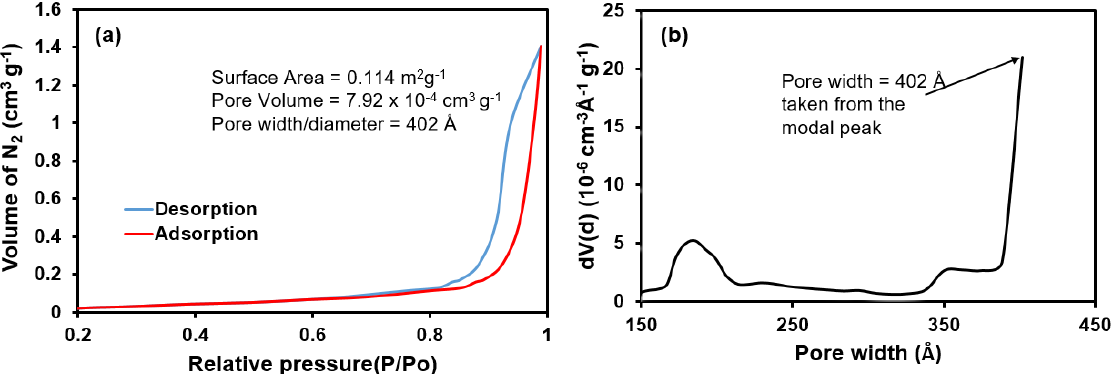
Figure 6. Brunauer–Emmett–Teller (BET) analysis of LLCZN/PEO/LiPF 6 composite: ( a ) adsorption– desorption isotherm curve and ( b ) pore size distribution.